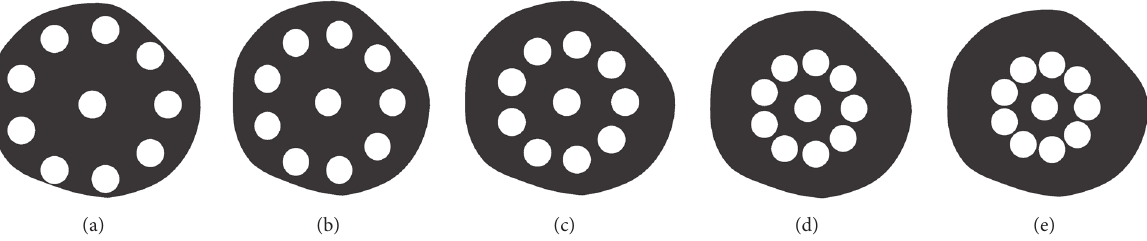
Figure 4: Circular holes in the cross-sectional area of the lotus root.